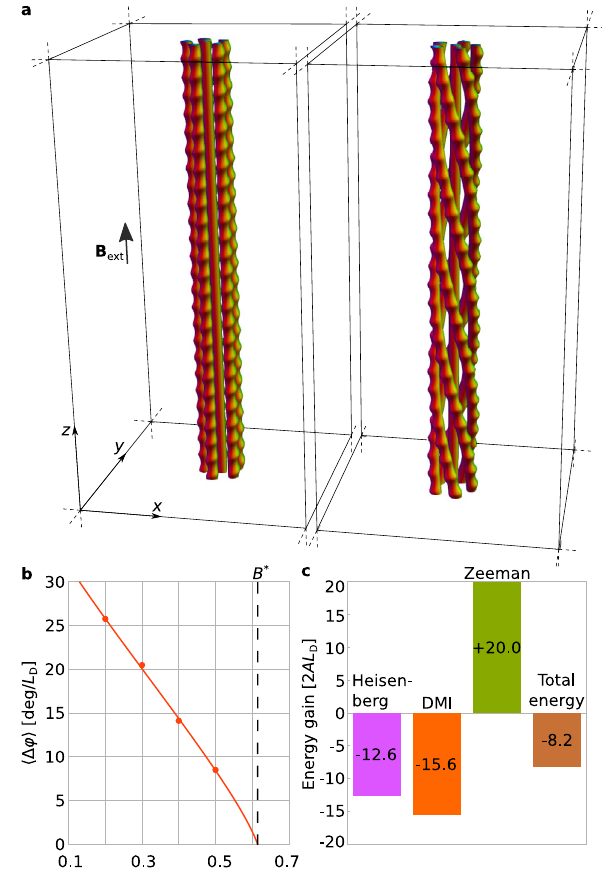
Fig. 2 Energy gain of a skyrmion braid in a bulk sample. a Cluster of six straight skyrmion strings (left) and a corresponding skyrmion braid (right) in a bulk sample with periodic boundary conditions in all three dimensions. b Dependence of energetically optimal twist per unit length on the applied magnetic fi eld calculated without dipole – dipole interactions. c Component- wise energy difference between a cluster of straight skyrmion strings and a skyrmion braid at B ext = 0.392 B c for a period along z equal to 25 L D , with 〈 Δ φ 〉 ≈ 14 deg/